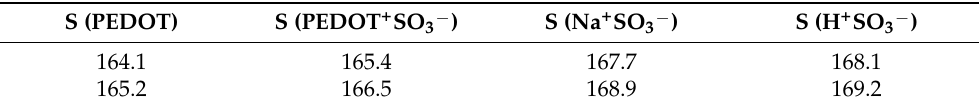
Table 2. Binding energies in eV of the sulfur species in different chemical environments available in the PEDOT/polysulfonates.